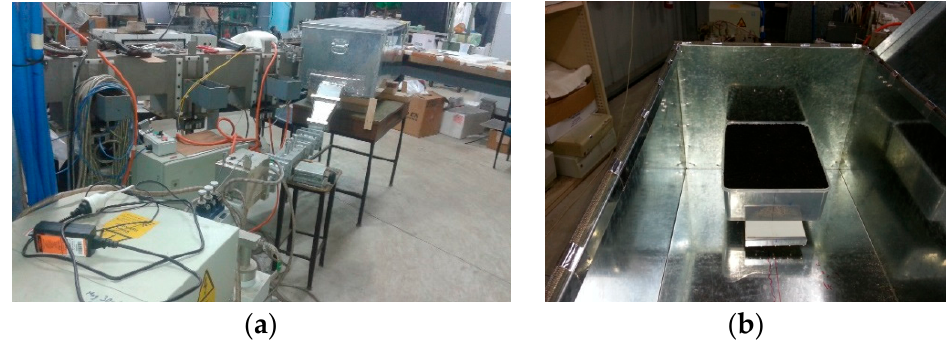
Figure 3. ( a ) Applicator (inside of metal box) connected to a 30 kW MW generator, operating at 2.45 GHz and ( b ) showing the soil sample set up on the applicator inside a metal box, which prevented stray radiation of microwave energy